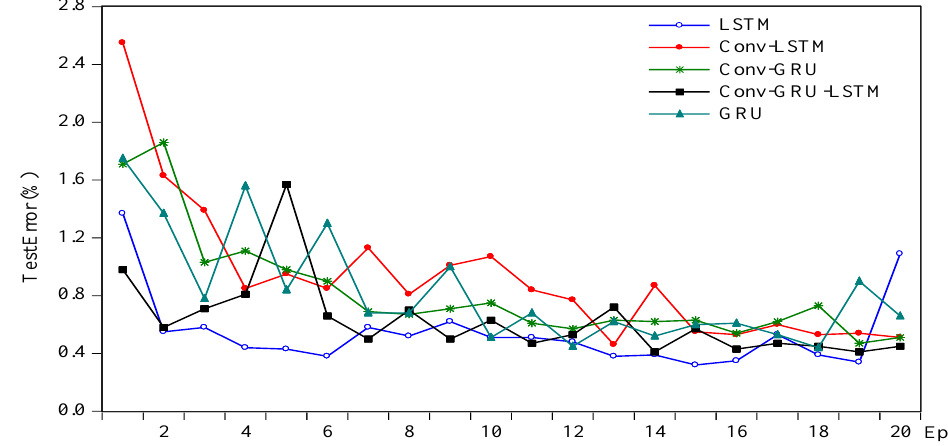
Figure 7. Comparison of each Epoch test error.